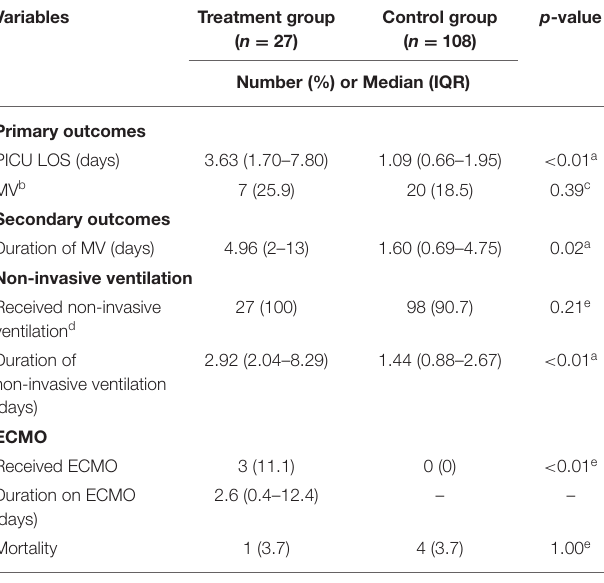
TABLE 3 | Primary and secondary outcomes comparing patients in treatment vs. control groups ( n =